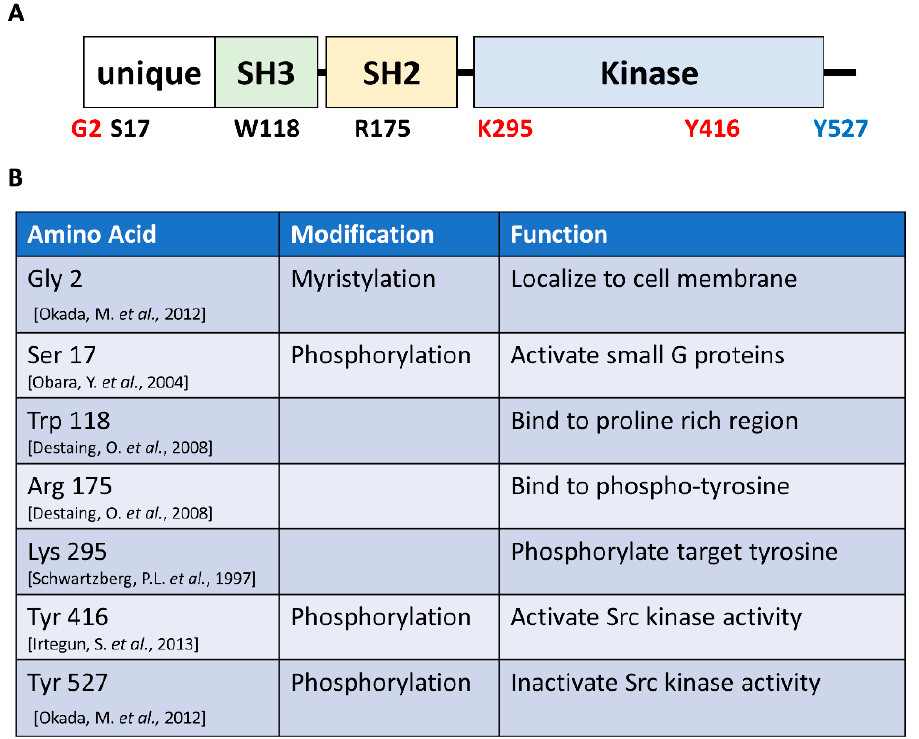
Figure 1. Schema of the domains of Src and the amino acids that play a critical role in its function: ( A ) Src comprises the unique, Src homology (SH) 3, SH2, and catalytic (kinase) domains. ( B ) Func- tional amino acids in Src.